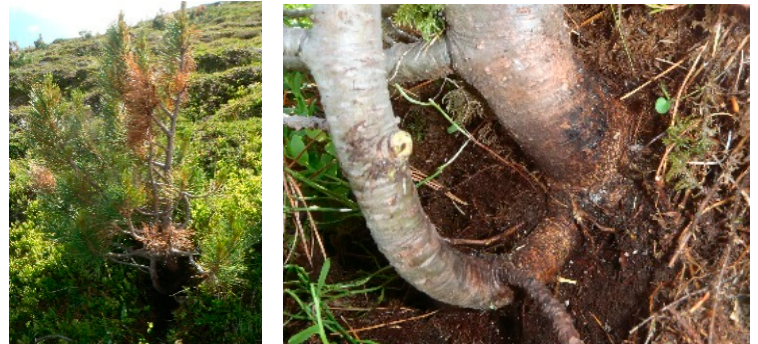
Figure 2. Multi-stemmed appearance of P. cembra individuals (single genet) showing strong needle damage on the wind-exposed side caused by ice particle abrasion and winter desiccation, while sheltered leeward side remained largely undamaged ( left ). Upright growing lower branch after vegetation and raw humus layer was removed ( right ).